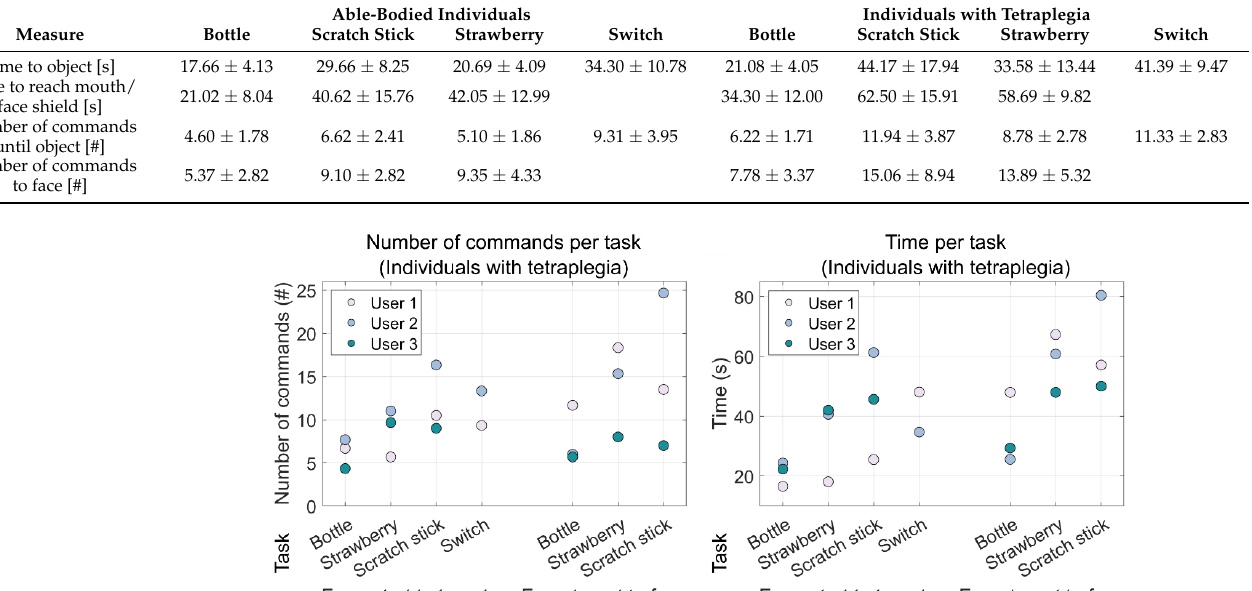
Figure 10. Boxplots of the mean performance metrics for able-bodied individuals. The two group- ings in each plot show the results the reaching phase and the moving object phase, respectively, and each column corresponds to each task: bottle, strawberry, scratch stick, and switch, respectively. ( a ) Shows the number of commands used during each phase of the task while ( b ) shows the time it took to complete each phase of each task. During the four ADL tasks for the users, the soft exoskeleton glove could sometimes not apply sufficient force due to the added elastic bands which led to dropped objects. In these cases, the users were asked to continue as if the object was still in their hands. The objects were then placed back in the hand by an experimenter while continuing the motion of the exoskeleton, and if needed the object was supported by the experimenter until the task was completed. This was only observed during the user tests and not during the tests with the able-bodied individuals. As the exoskeleton glove was not the focus of this work, this was not considered for performance metrics. There were no occurrences of AD during the experiments. For an image series showing the strawberry task with a user, see Figure 11. For video sequences of the ADL tasks, see Video S1.